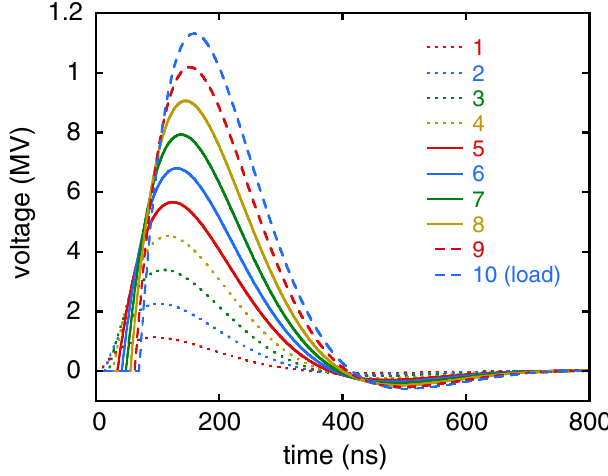
FIG. 6. Simulated voltage time histories at the outputs of the ten transmission-line segments of the ten-stage IMG illustrated by Fig. 4, as given by the circuit model of Fig. 5(a). Since 10 Z ¼ Z , the voltage at the output of the tenth stage is load identical to that at the